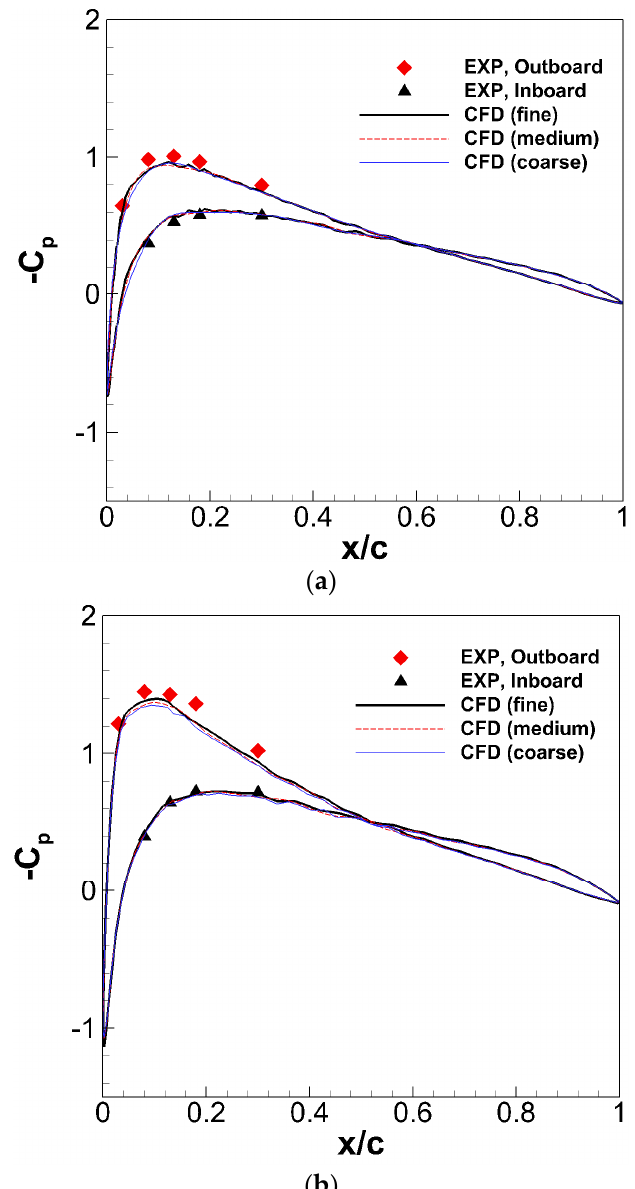
Figure 4. Pressure distributions along the chord lines on the flat rudder: ( a ) z/s = 0.45; ( b ) z/s = 0.6.